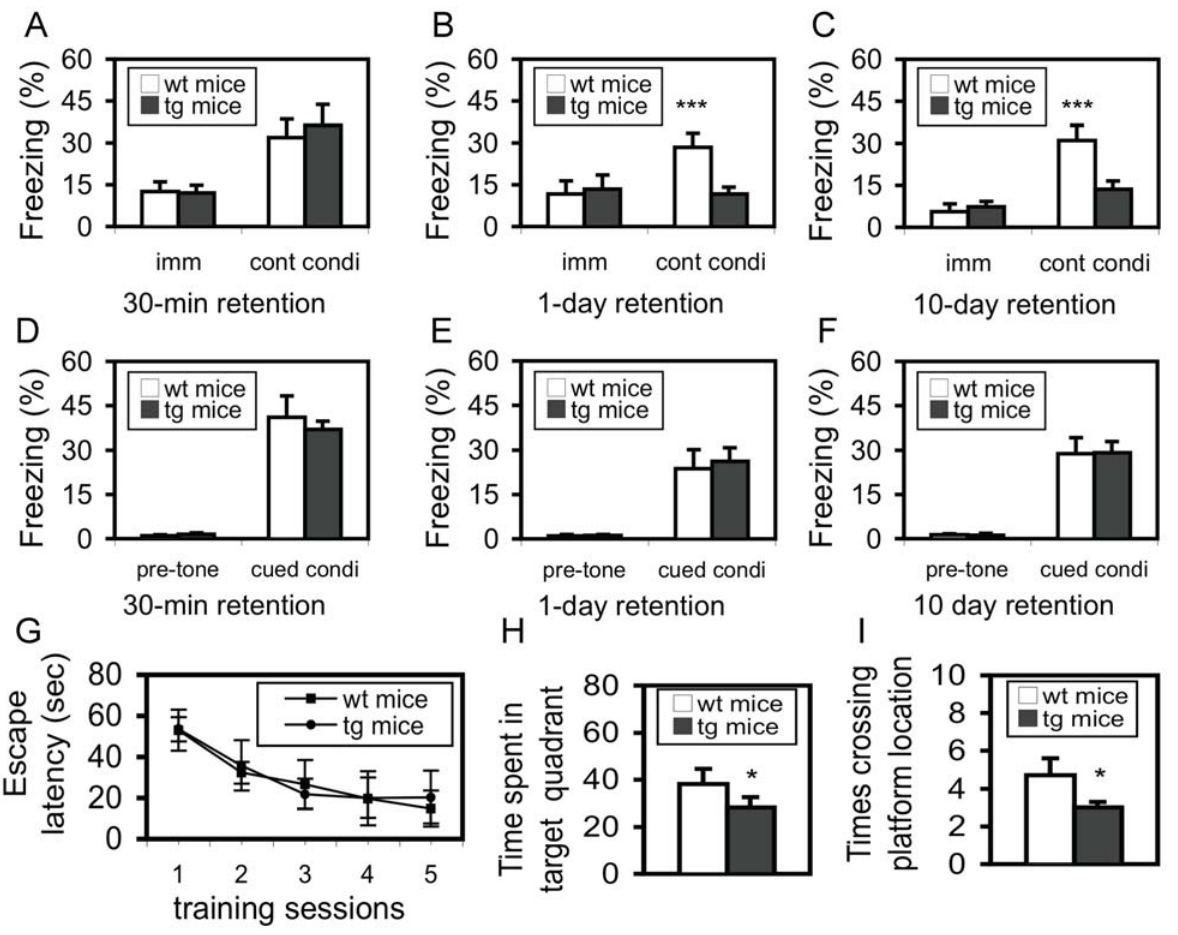
Figure 7. Long-term, but not short-term, hippocampus-dependent memory is impaired in hip-eEF-2K-tg mice. A . Short-term memory in contextual conditioning was measured at 30 min after the training. No significant difference was observed in either immediate (imm) freezing after shock or contextual conditioning (cont condi) between wild-type (wt, n=10) and hip-eEF-2K-tg mice (tg, n=13). B . Short-term memory in cued conditioning was measured at 30 min after the training. No significant difference was observed in either pre-tone freezing or cued conditioning (cued condi) between wt (n=10) and tg mice (n=13). C . Long-term memory in contextual conditioning was measured at 1 day after training. While no significant difference was observed in immediate freezing after shock, a highly significant difference was found in contextual conditioning between wt (n=10) and tg mice (n=12). ***, p , 0.001, Student’s t test. D . Long-term memory in cued conditioning was measured at 1 day after training. No significant difference was observed in either pre-tone freezing or cued conditioning. E . Long-term memory in contextual conditioning was measured at 10 days after the training. While no significant difference was observed in immediate freezing after shock, a highly significant difference was found in contextual conditioning between wt (n=11) and tg mice (n=12). ***, p , 0.001, Student’s t test. F . Long-term memory in cued conditioning was measured at 10 days after training. No significant difference was observed in either pre-tone freezing or cued conditioning. G . Learning curve in a water maze test; repeated ANOVA did not reveal a significant difference between wt (n=11) and tg (n=12) mice. H . Time spent in the target quadrant in a probe test 24 hr after the completion of the training sessions. *, p , 0.05, Student’s t test. i . Number of crossing over the platform location in the probe test 24 hr after the completion of the training session. *, p , 0.05, Student’s t